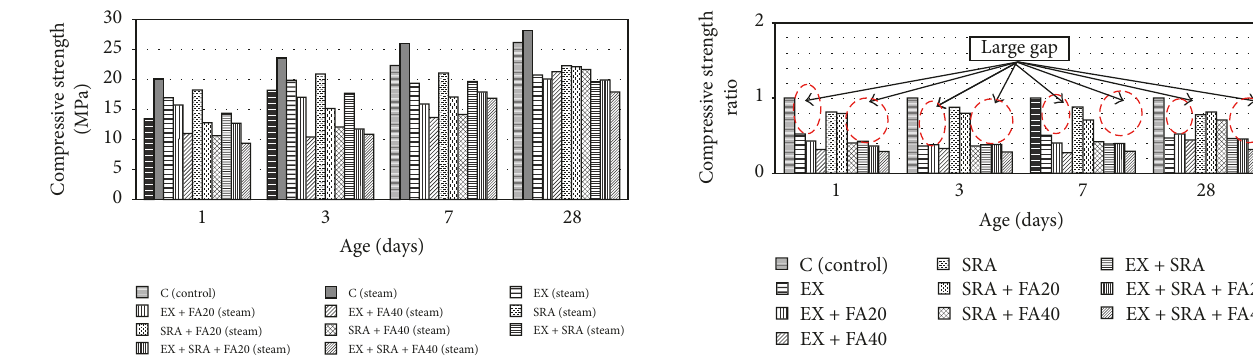
Figure 6: Compressive strength ratio of normal-cured mortar.